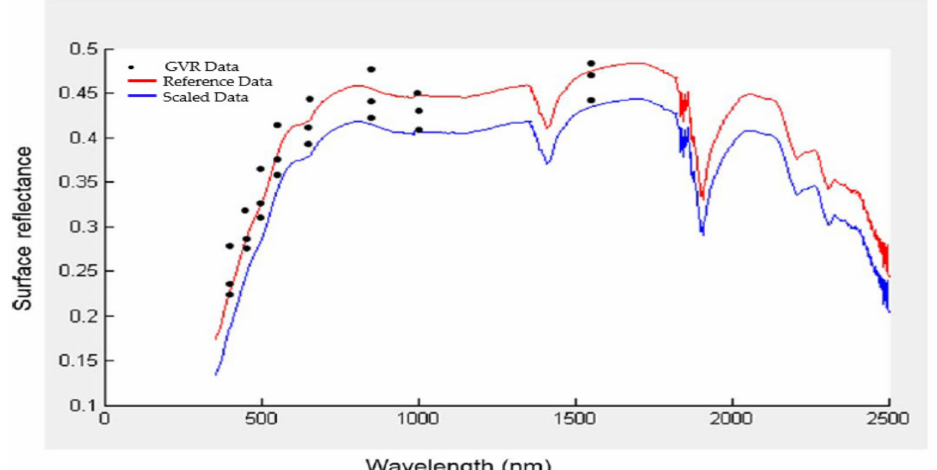
Figure 6. Ground-viewing radiometer (GVR) multispectral SR data used to scale original hyperspectral SR reference data to create hyperspectral SR data for RadCalNet [13]. The reference data (blue) are scaled up or down based on the GVR data (black